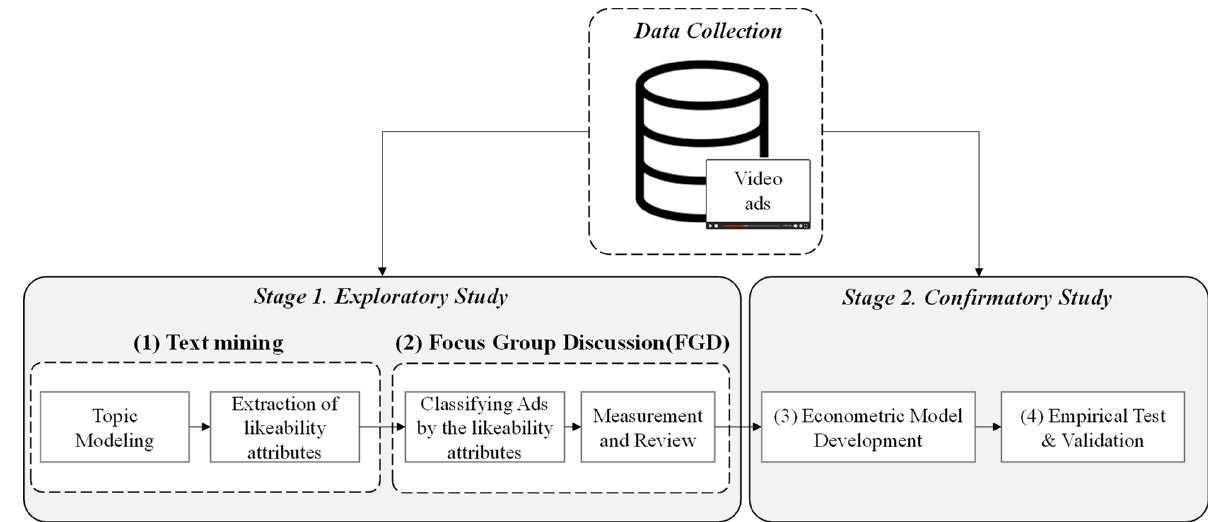
Figure 1. Research procedure.